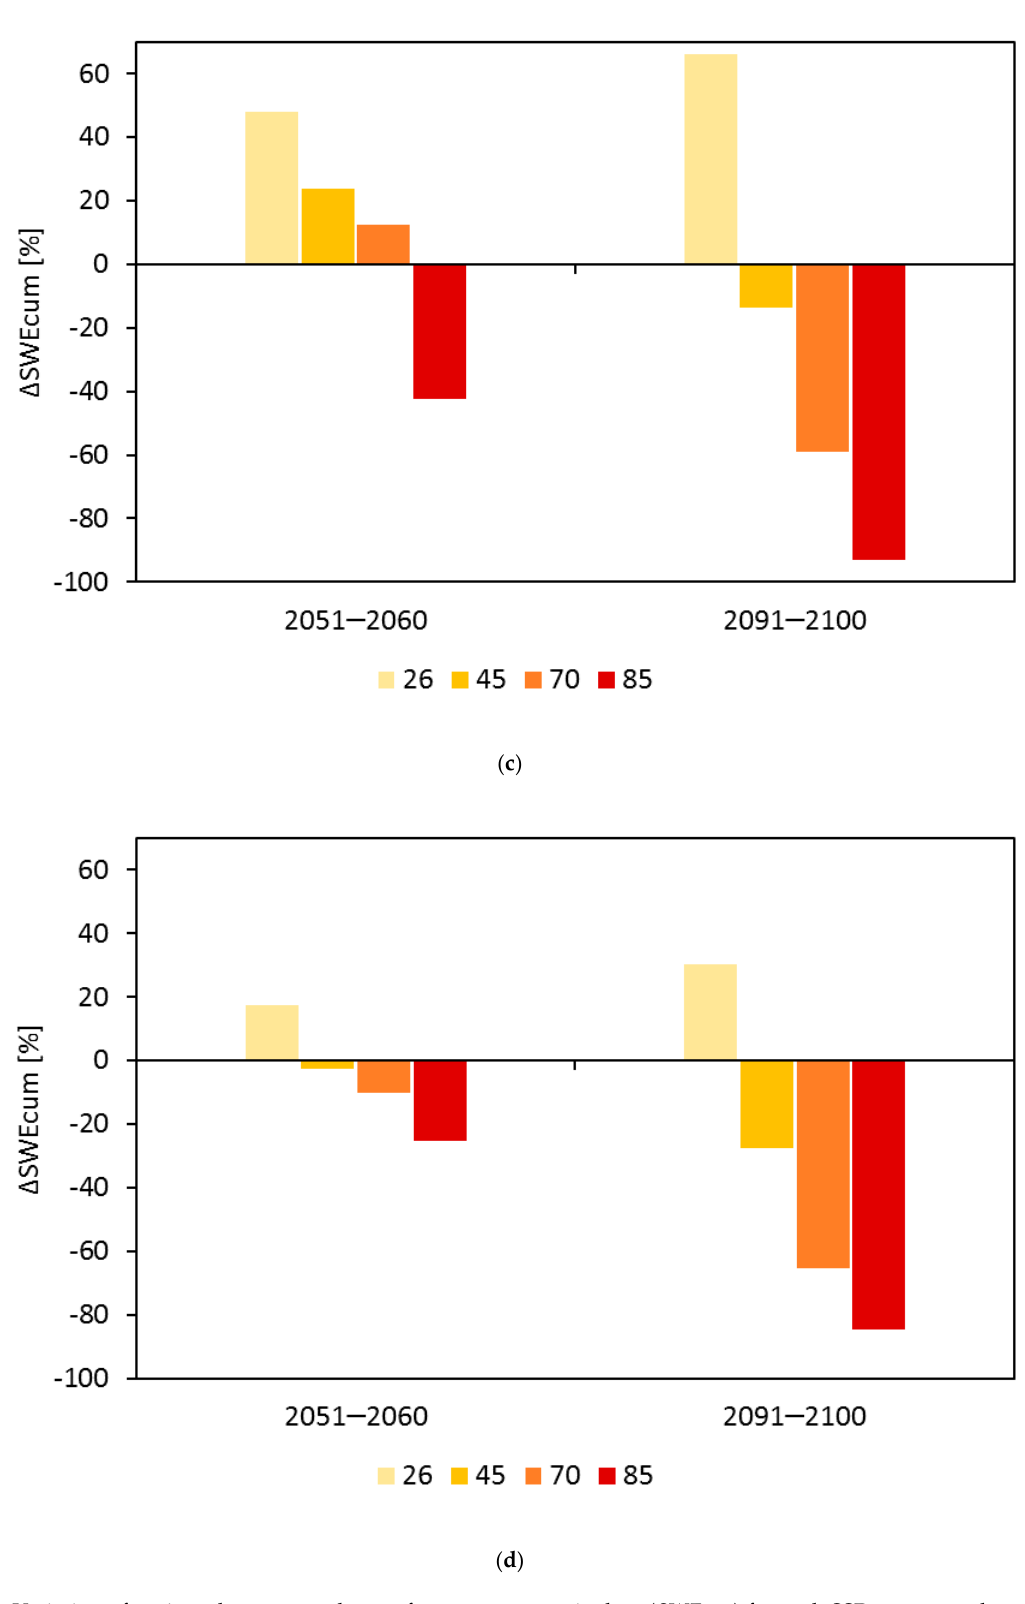
Figure 9. Variation of projected average volume of snow water equivalent ( SWE cum ) for each SSP respect to the control run (CR) period. ( a ) April. ( b ) June. ( c ) September. ( d ) December.